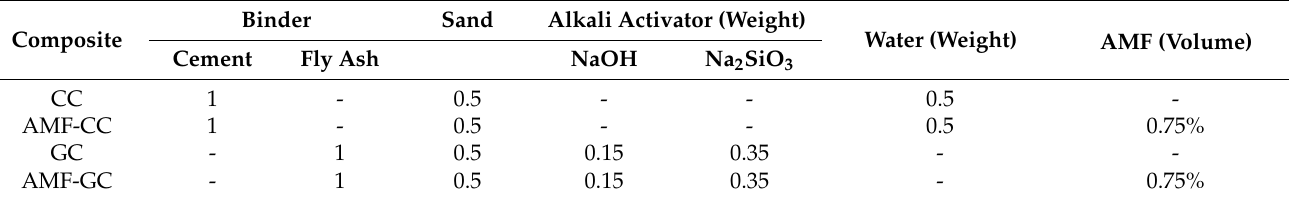
Table 2. Mix proportions of cement and geopolymer composites.